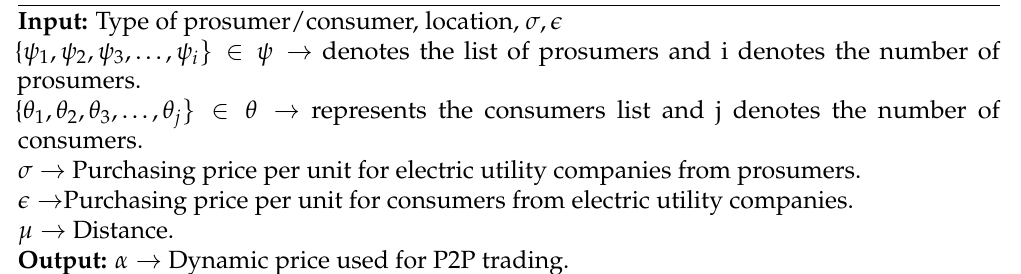
Algorithm 1 Publishing Energy Data on Ethereum blockchain and P2P